Question: In a single sentence, describe what this figure presents.
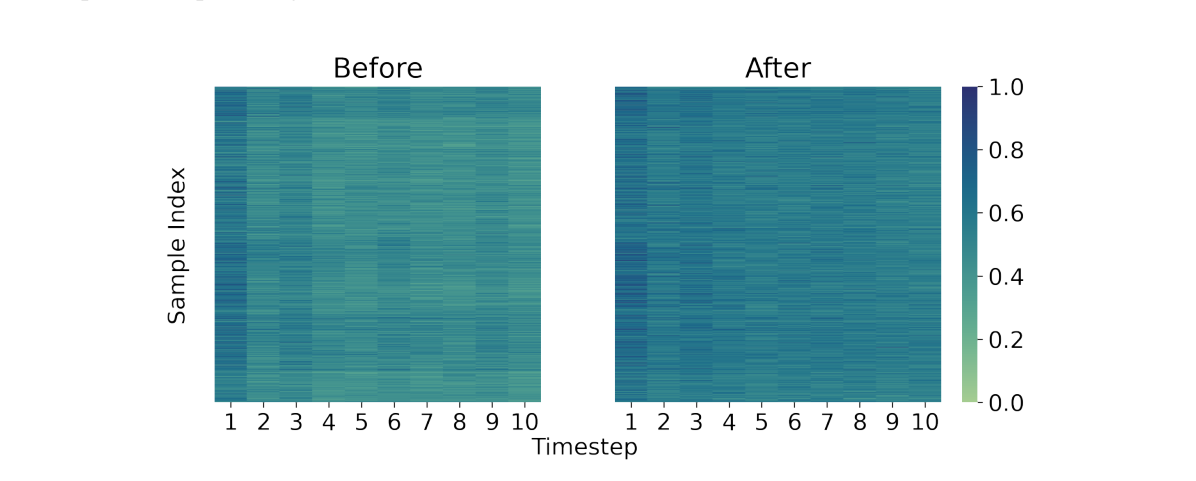
Answer: Visualisation of STF ξl(t) at 8-th layer in two models, before and after regularisation, on Cifar10-DVS. Regularisation leads to a reduction in variance of ξl(t) from 0.0025 to 0.0022, indicating enhanced stability across timestep. Additionally, the mean value of ξl(t) rises from 0.2736 to 0.3336, reflecting an enhancement in the representation of spatial information ∥θl(t)∥2.